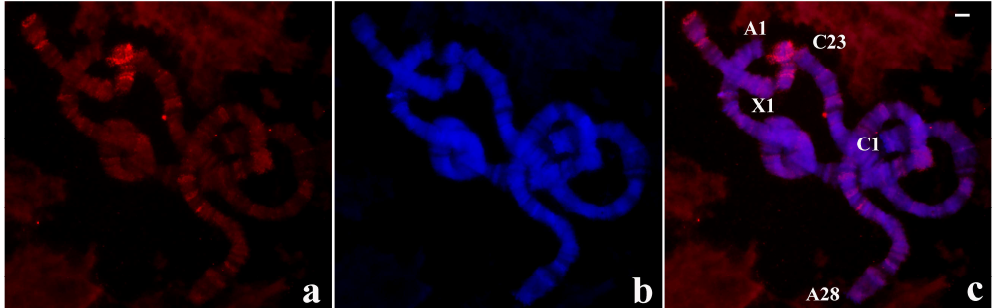
Figure 10. ( a ) Localization of the p Tp -2.4 probe (red signal) in chromosomes of T. pubescens. ( b ) The same chromosomes stained with DAPI and ( c ) the merged hybridization and DAPI signals. Bar = 15 µ m.